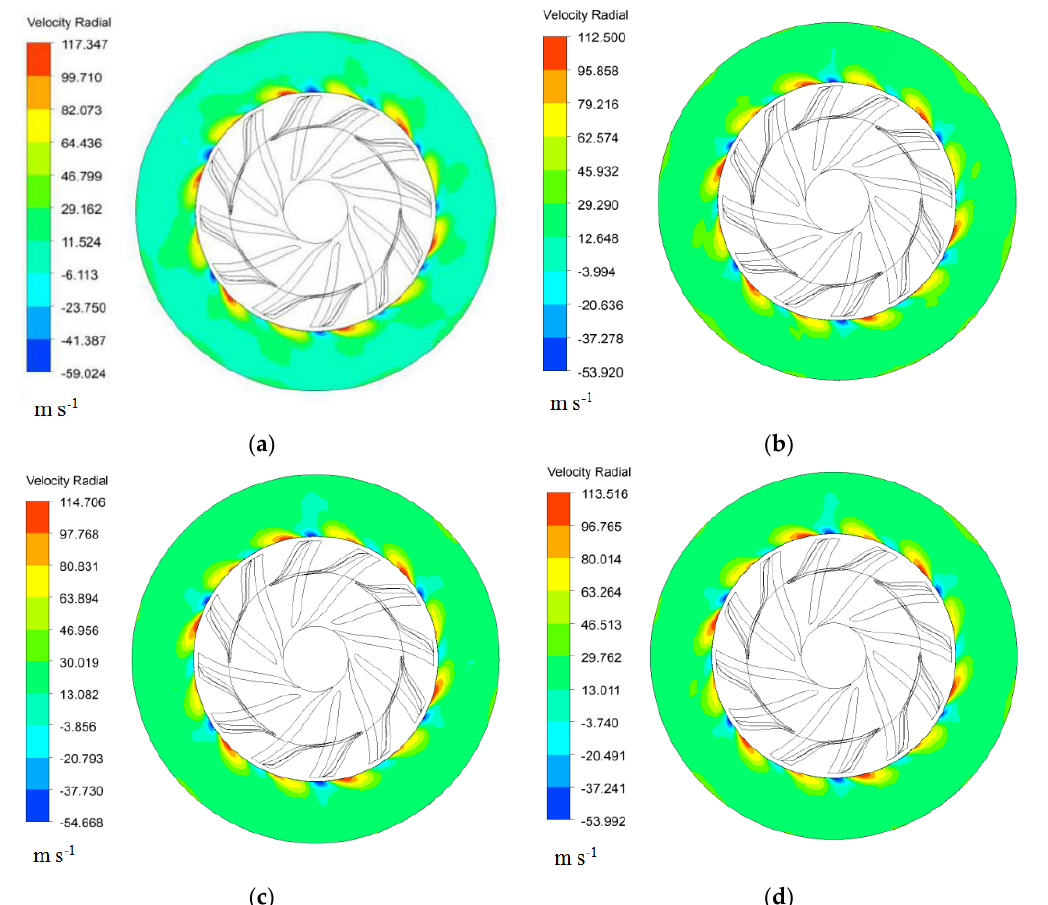
Figure 8. Seventy percent span height radial velocity distribution at 1.125 relative mass flow: ( a ) parallel; ( b ) convergence from shroud; ( c ) convergence from hub; ( d ) equal convergence from shroud and hub.